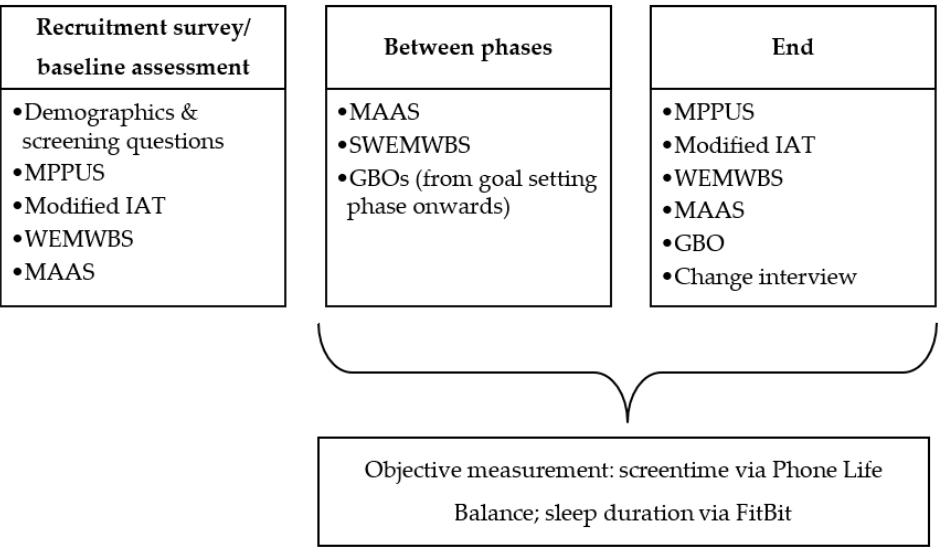
Figure 1. An outline of the stages at which each of the measures was completed.